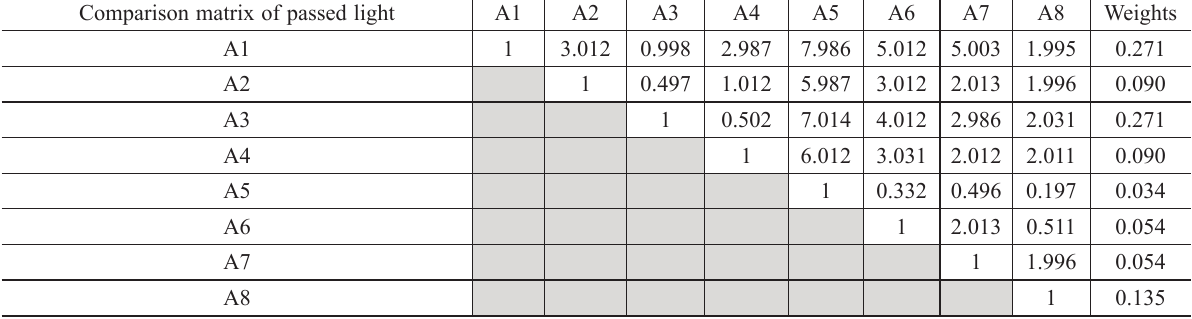
Table 8. Importance degree of any laminated glass models related to passed light degree Comparison matrix of passed light